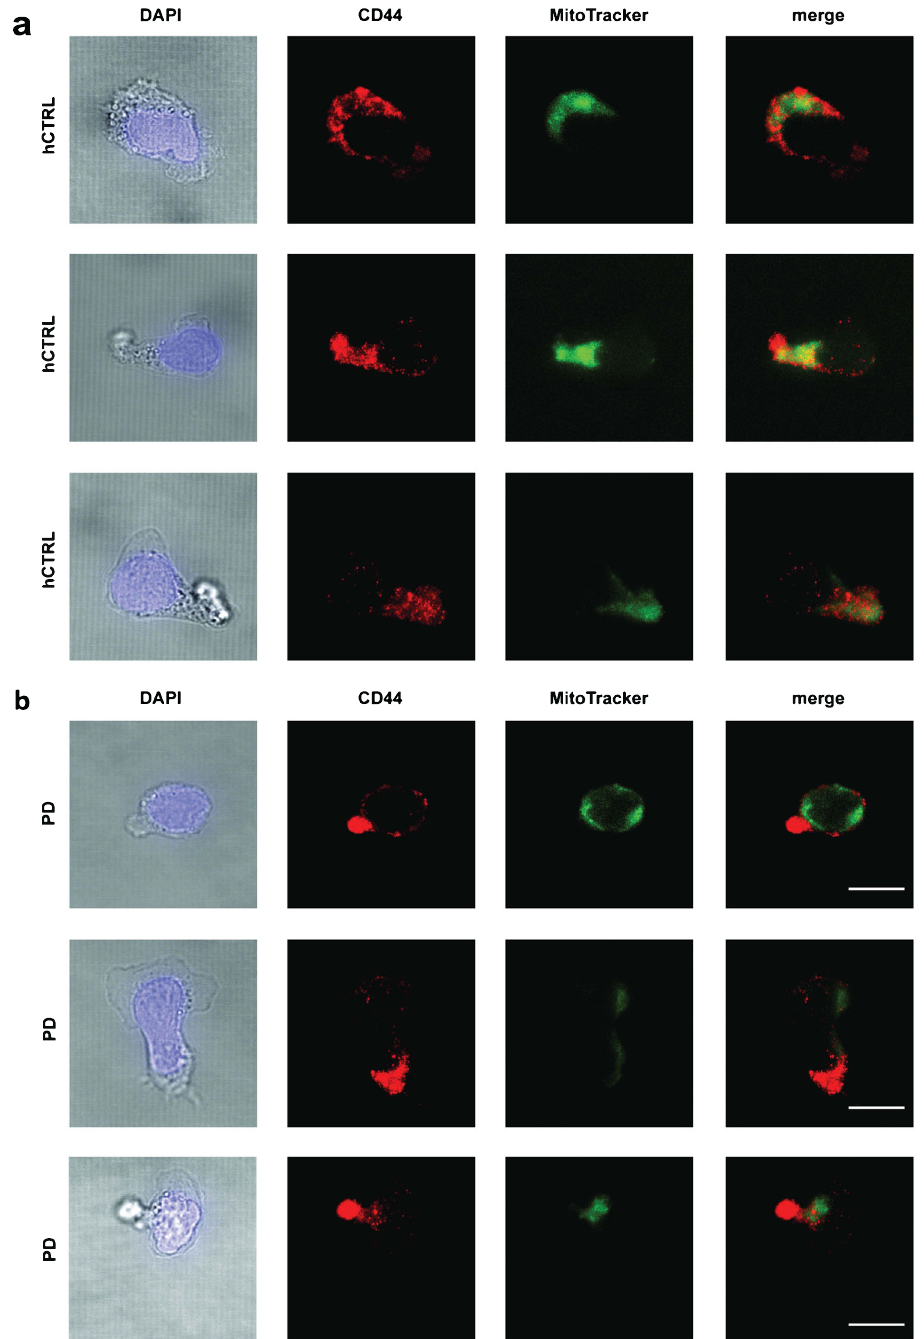
45 min at 37 °C. Thereafter the cells were fi xed, permeabilized and stained. a Representative bright fi eld and confocal images of DAPI (blue), MitoTracker (green), and CD44 (red) in single CD4 + T cells derived from healthy subjects and b PD patients. The images are obtained from three independent experiments. Scale bar, 10 μ